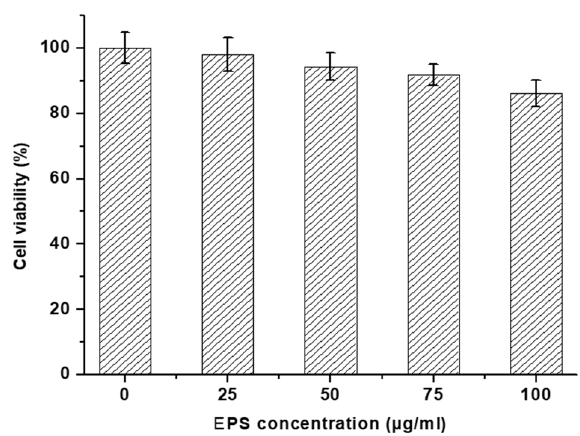
Figure 10. Cell viability assay of marine archaeal EPS obtained from Halococcus sp. AMS12.